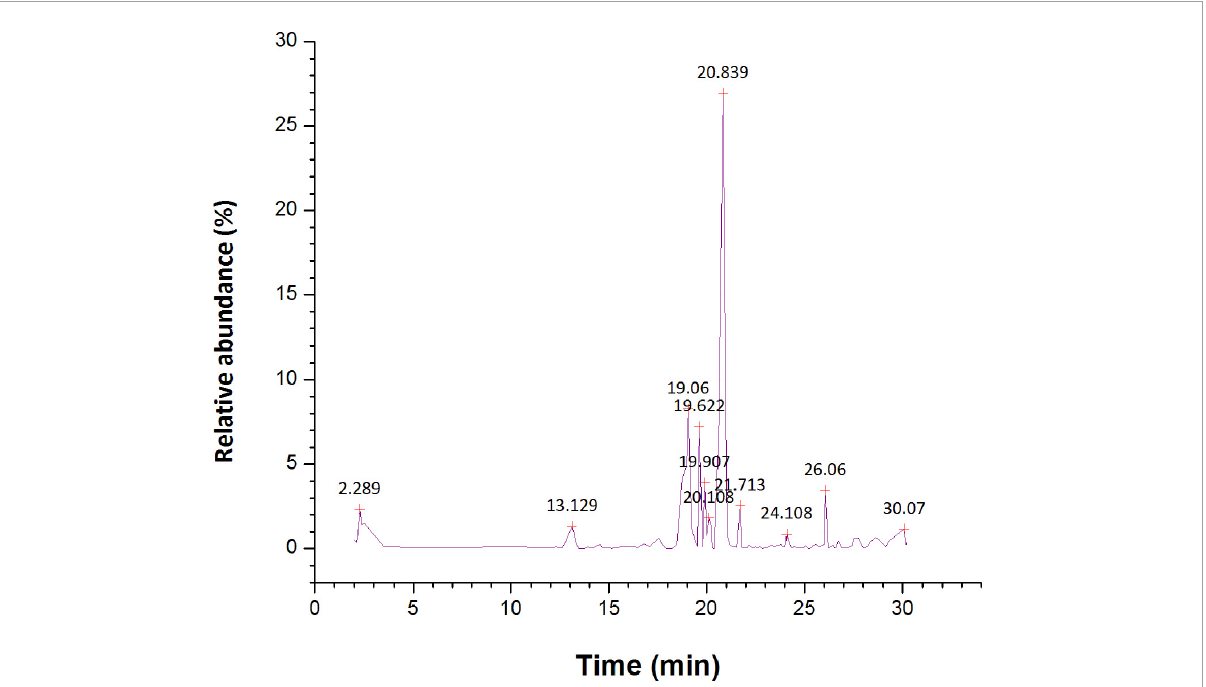
FIGURE5 Gas chromatography-mass spectrometer (GC-MS) chromatogram for major compounds of n -hexane root extract of Skimmia anquetilia .